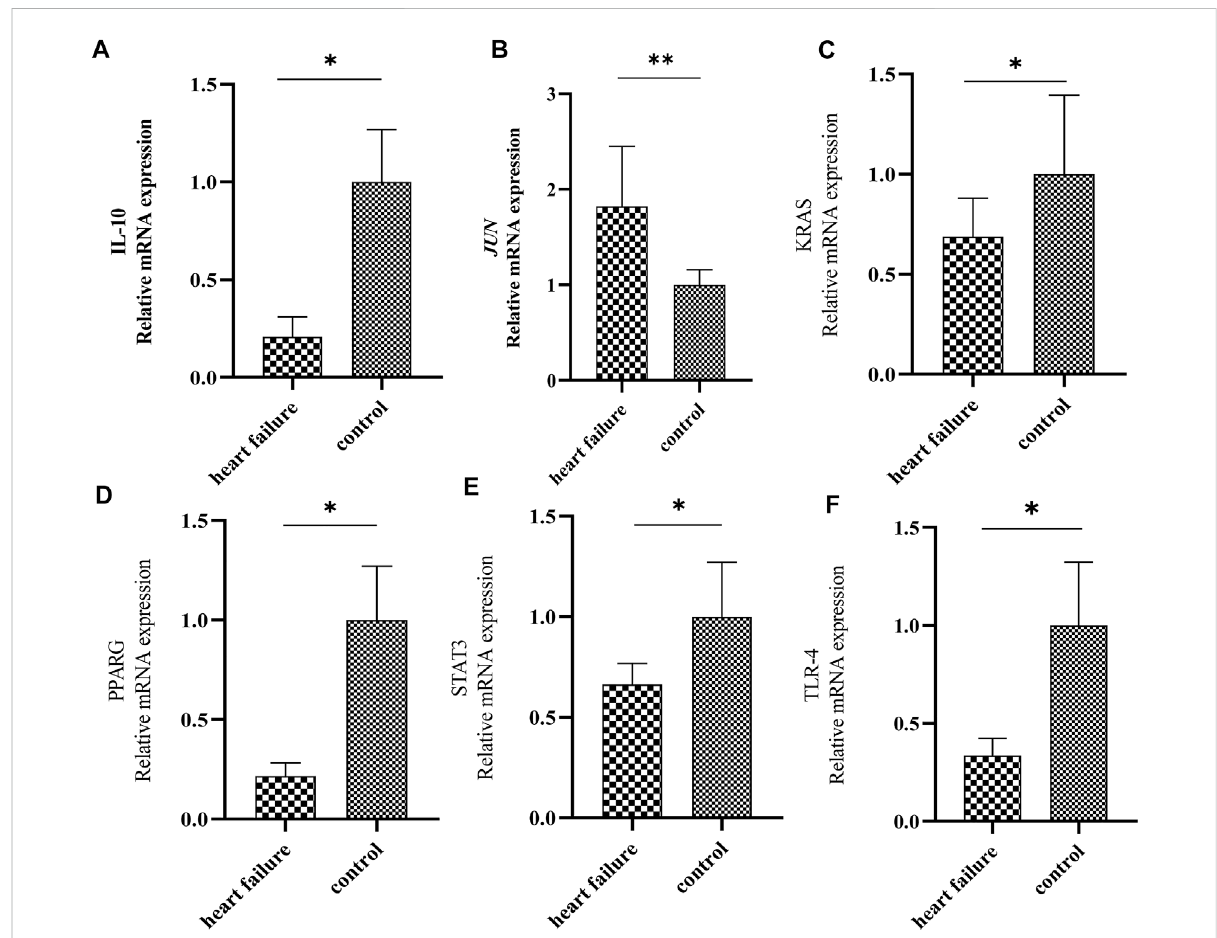
FIGURE 5 Validation of the expression of 6 hub genes by quantitative real time PCR. The levels of IL-10 (A) , JUN (B) , KRAS (C) , PPARG (D) , STAT3 (E) and TLR4 (F) in plasma samples from patients with HF and healthy controls were measured by qPCR. Results were shown as mean ± SD. * p < 0.05 ** p < 0.01 vs. control. GAPDH was used as housekeeping